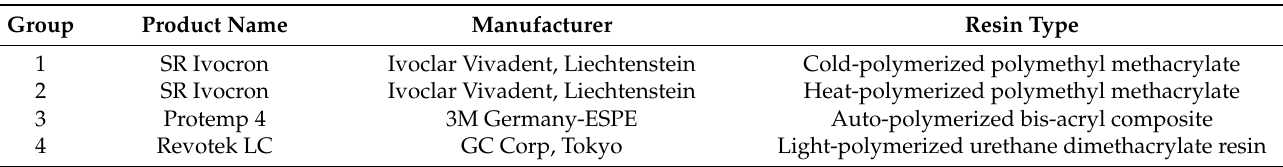
Table 1. Materials tested: The four different types of provisional restoration materials and their